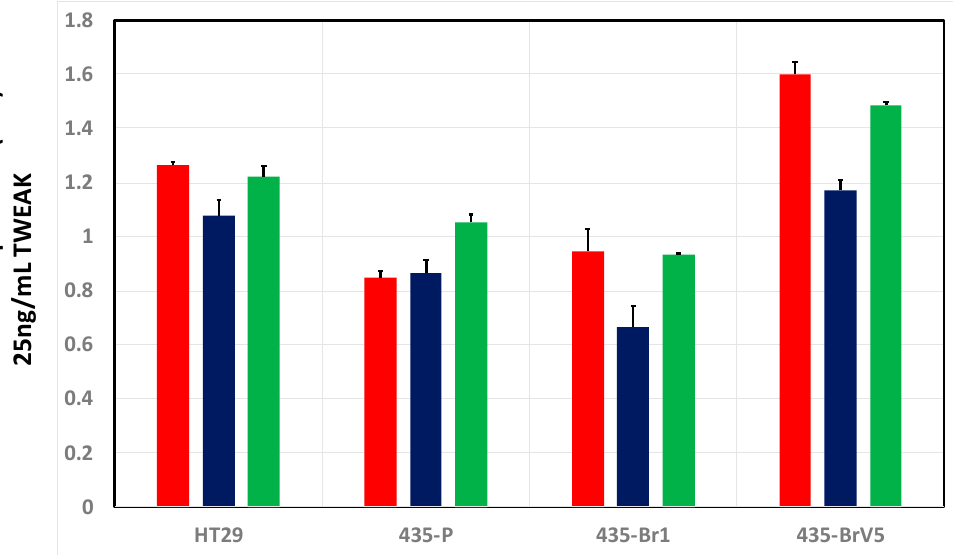
Figure 2. NIK activation in brain metastatic cells. Metastatic cells were primed with TWEAK in a time-course RT-PCR experiment. The bar chart shows activation of NIK (shown as mRNA relative expression) at 6 h (red), 12 h (blue) and 24 h (green). Bars and error bars represent the average and standard deviation as calculated from three replicates respectively.